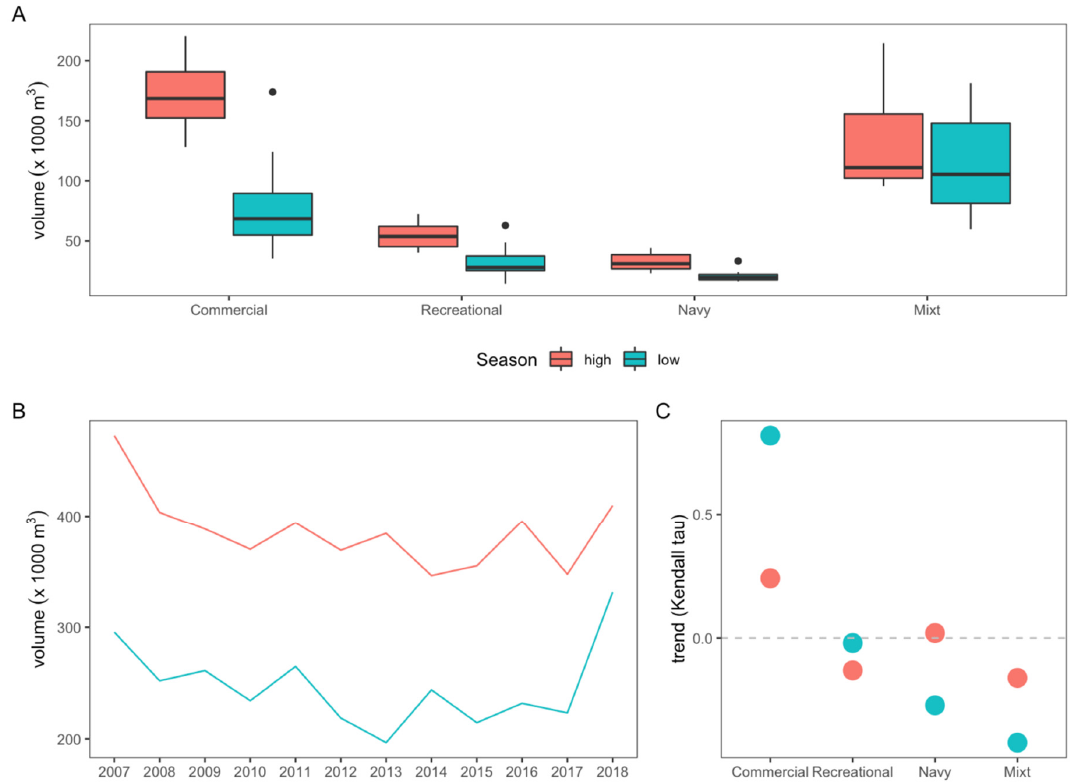
Figure 3. ( A ) Boxplots showing the distribution of water use by sectors and seasons during the period 2007–2018. (Solid lines: median; boxes: first and third quartiles; whiskers: 10th and 90th percentiles; dots: 5th and 95th percentiles). ( B ) Trend of temporal evolution for the period 2007–2018 of water withdrawals for the high and low tourist seasons. ( C ) Results of the Mann–Kendall trend test in the four sectors, classified by high and low tourist season, with y axis showing Kendall tau coefficient.